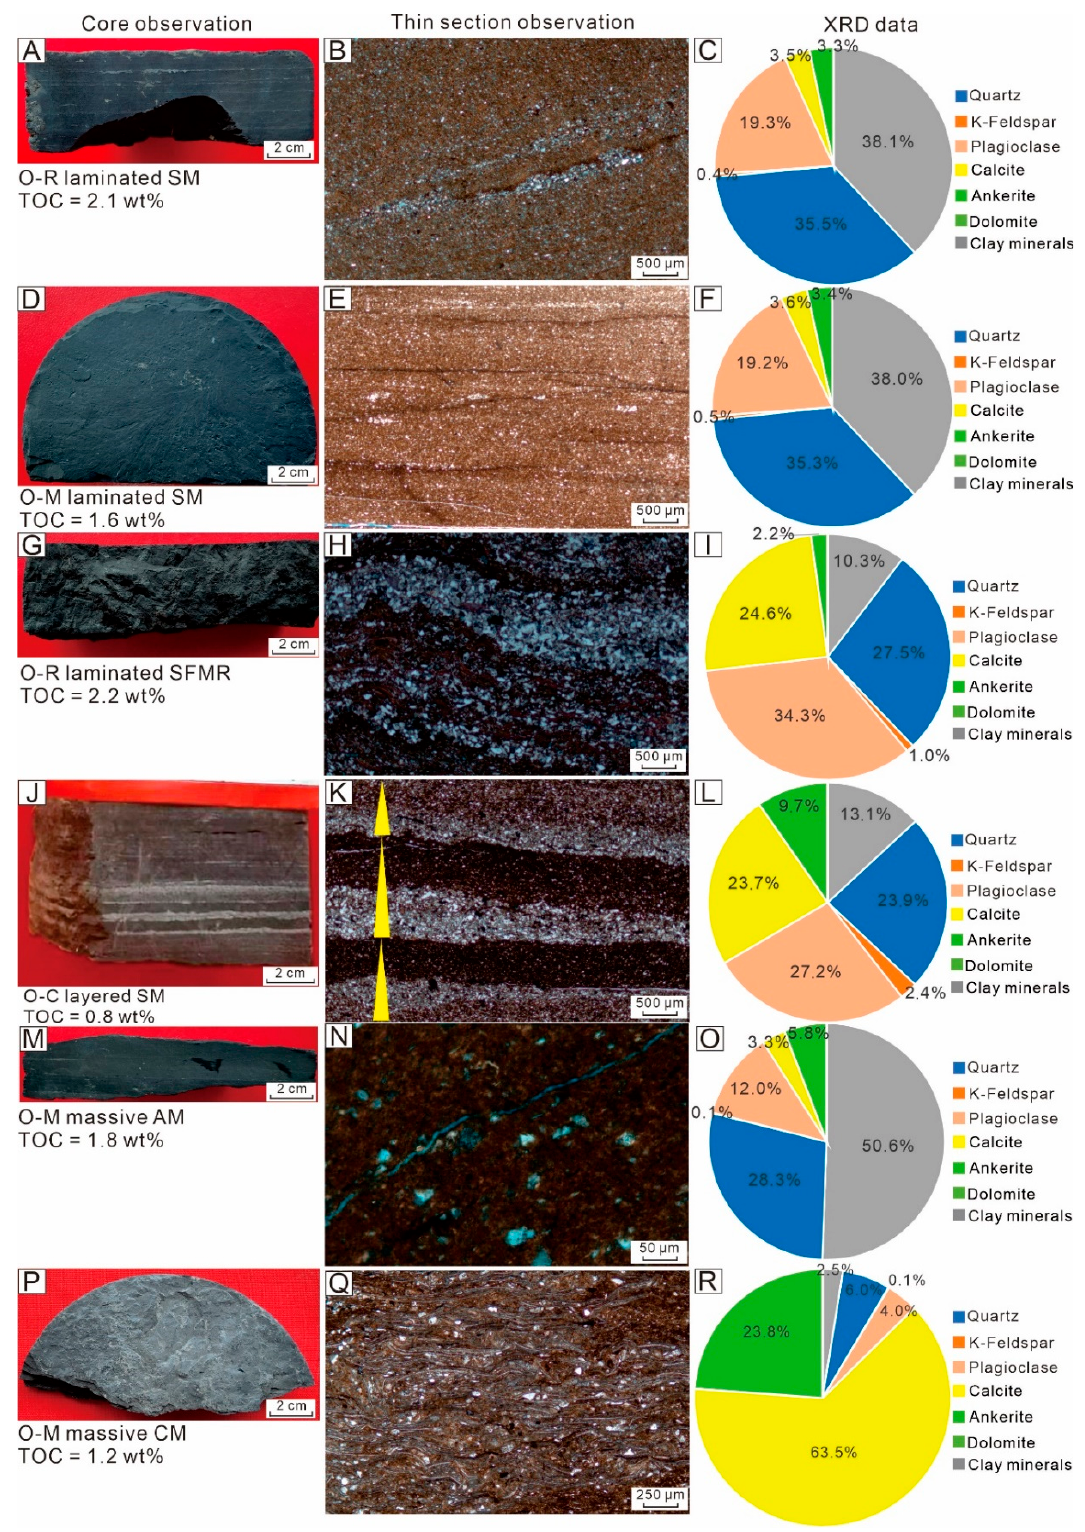
Figure 10. The main lithofacies types of FGSRs in the Qingshankou Formation. ( A – C ) O ‐ R laminated SM, well X3HC, 2452.0 m; ( D – F ) O ‐ M laminated SM, well X2HC, 2327.35 m; ( G – I ) O ‐ R laminated SFMR, well X3HC, 2488.1 m; ( J – L ) O ‐ C layered SM, well X7, 2453.6 m; ( M – O ) O ‐ M massive AM, well X8HC, 2382.1 m; ( P – R ) O ‐ M massive CM, well X1, 2578.01 m.